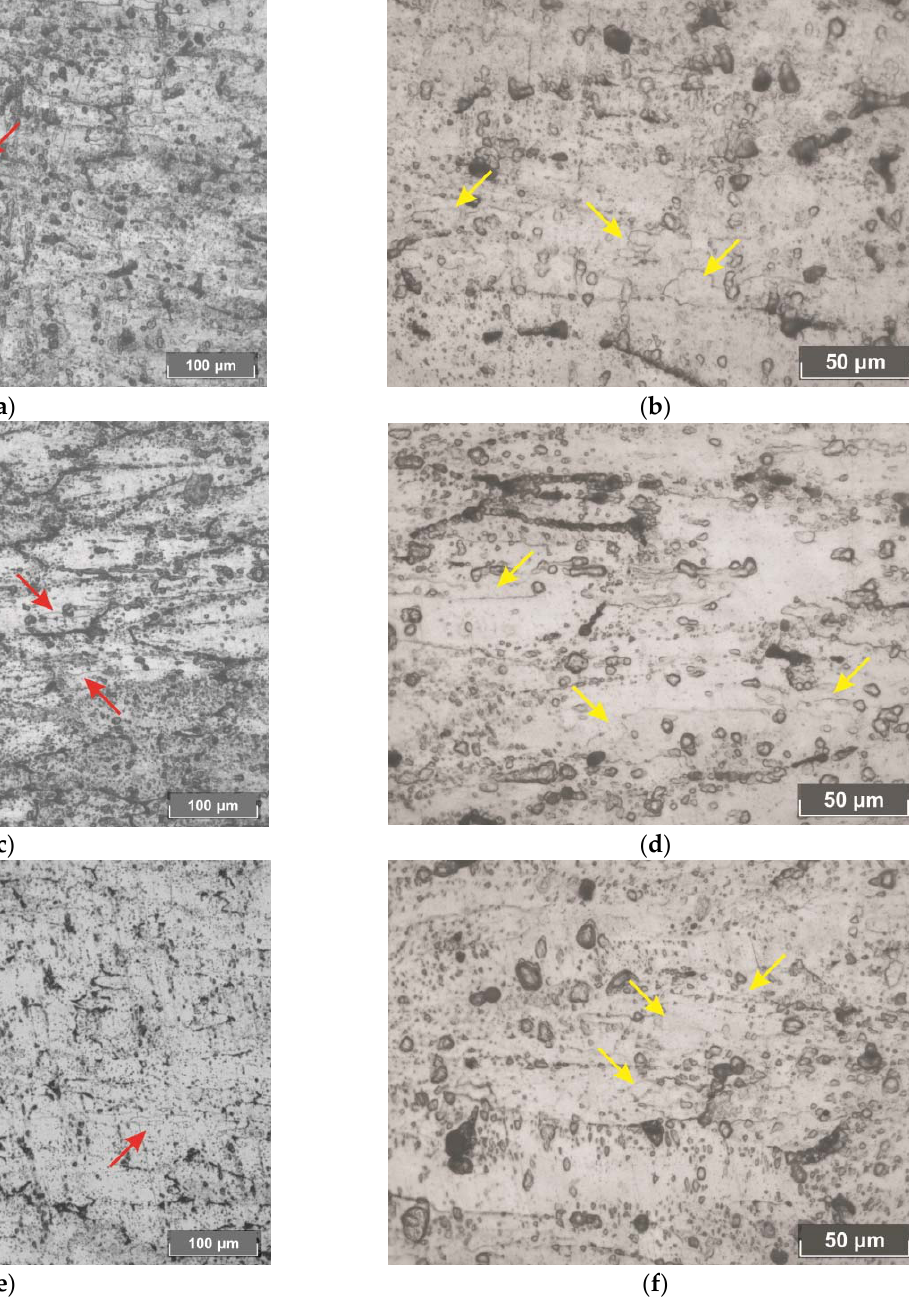
Figure 7. Dynamically recrystallized grains in the longitudinal section of the hollow shells after piercing by the entire plug ( a , b ), the plug with a cavity ( c , d ), and the hollow plug ( e , f ). The hardness variation along the walls of the hollow shells pierced by the different plugs is given in Figure 8. In other words, Figure 8 illustrates how hardness changes in the cross-section of the hollow shells at the stationary stage, according to the measuring scheme in Figure 4a. The markers in Figure 8 indicate the average values, and error bars are given next to them. It is worth noting that the average value of hollow shell diameter was 60.6 mm after entire plug piercing, 61 mm after plug with a cavity piercing, and 60.1 mm after hollow plug piercing. The average value of wall thickness was 14.7 mm after